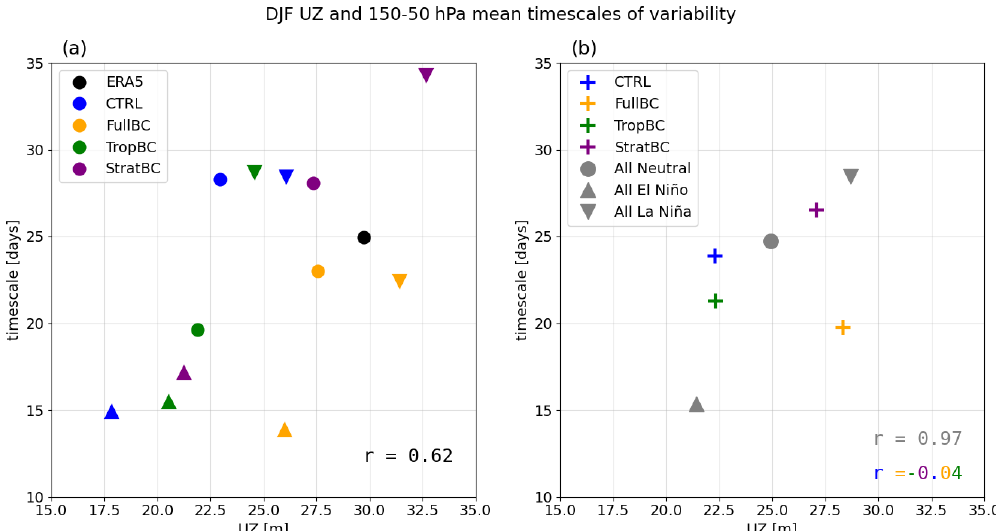
Figure 3. Mean DJF zonal mean zonal wind at 60 ◦ N 10hPa plotted against the weighted average from 50–150hPa of timescales of polar cap geopotential height ( Z cap ) from Fig. 2. (a) Circles are neutral ENSO conditions, upward-pointing triangles are El Niño experiments, and downward-pointing triangles are La Niña experiments. Correlation coefficient for all models and ENSO phases: r = 0 . 62. (b) Coloured crosses show the mean of El Niño, La Niña, and neutral conditions for each experiment (corr. coef.: r = − 0 . 04). The grey circle and triangles show the multi-model mean for each ENSO phase (corr. coef.: r = 0 . 97). ERA5 data from 1979–2019, 100 years for each model run (neutral, El Niño, and La